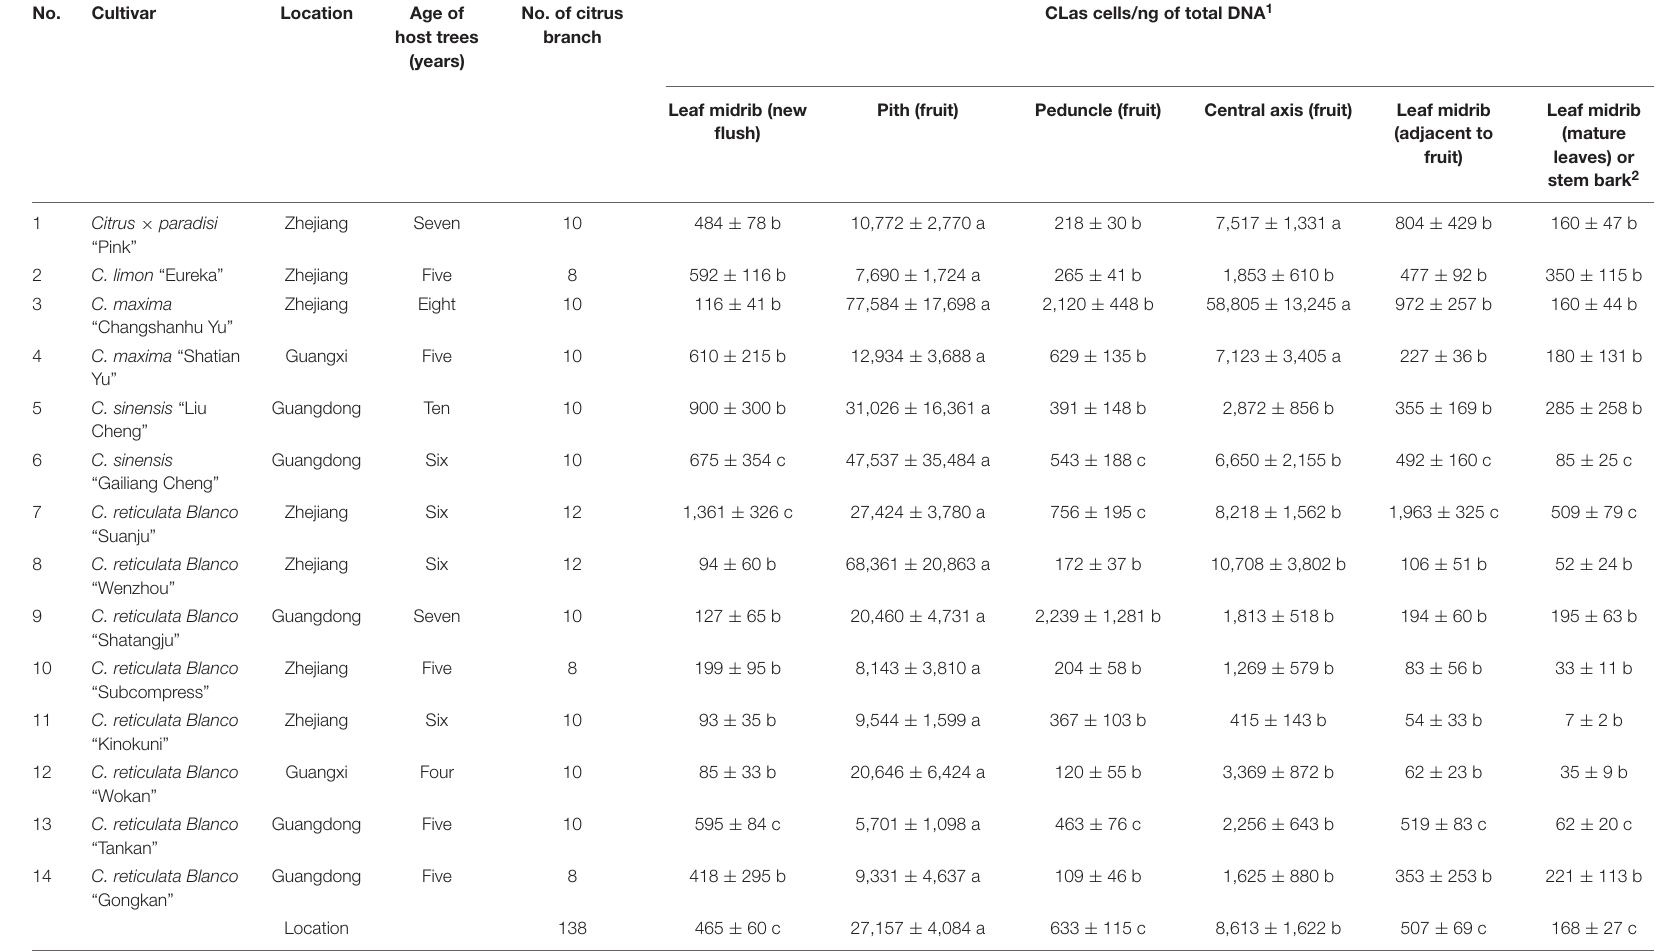
TABLE 1 | Quantification of “ Candidatus Liberibacter asiaticus ” (CLas) from six different parts of huanglongbing-affected citrus branches from 14 citrus cultivars.